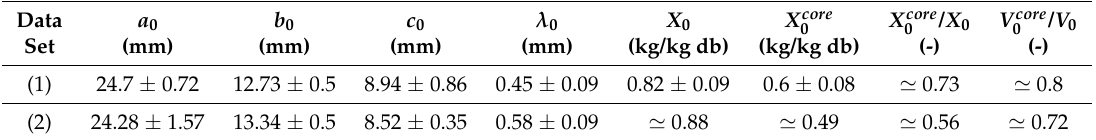
Table 1. Morphological and physical parameters of two different sets of freshly fermented Amazonian cocoa beans. Data set (1) are reported in [9]. Data set (2) are reported in